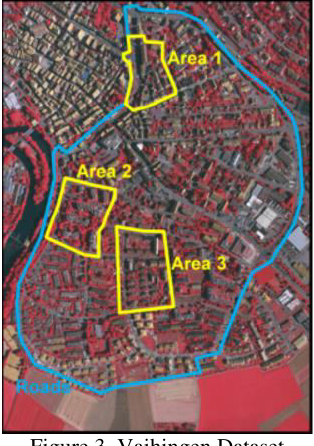
Figure 3. Vaihingen Dataset